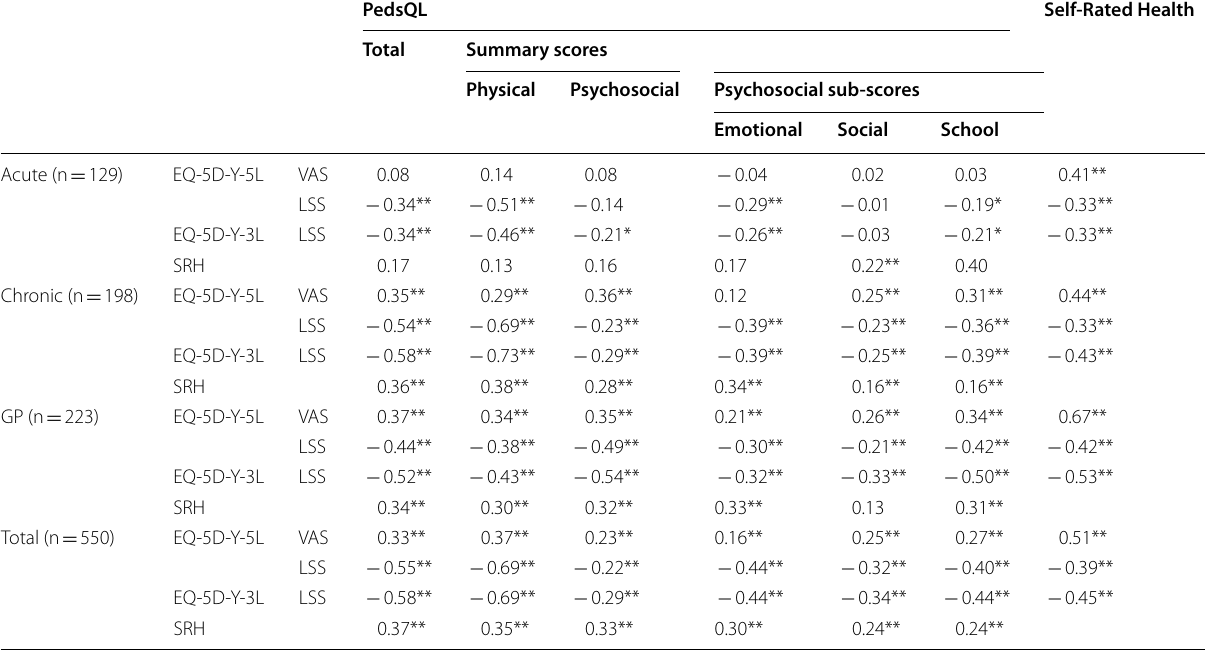
Table 4 Summary of concurrent validity with the PedsQL summary and sub-scores, Self-Rated Health and EQ-5D-Y-3L and EQ 5D-Y-5L LSS and VAS scores with Pearson correlation =